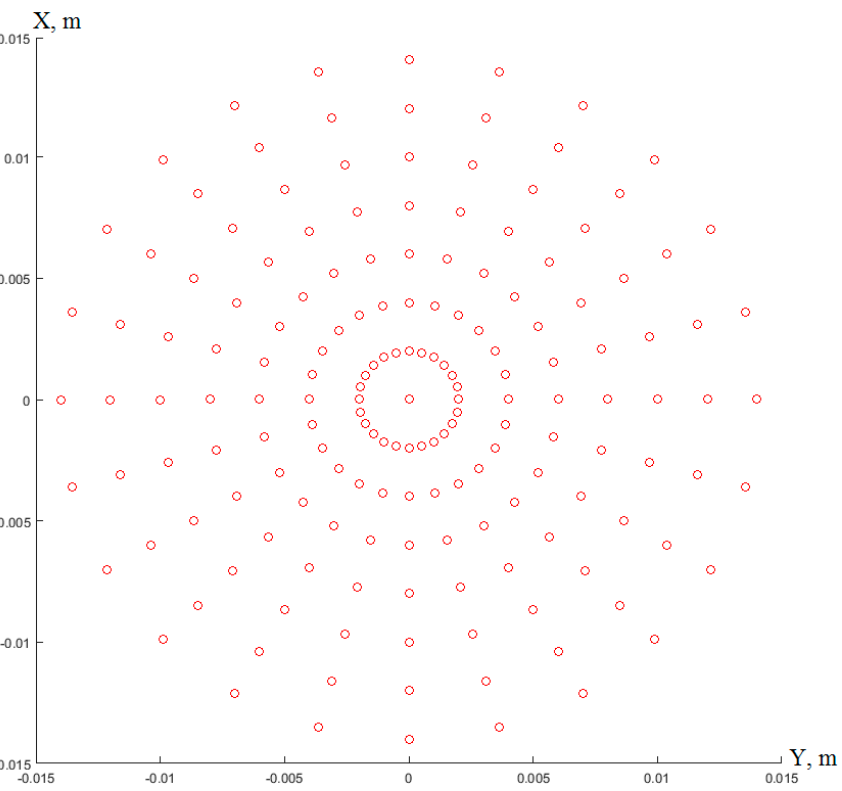
Figure 8. Array of points at the resonator backing for recording the acoustic pressure in numerical